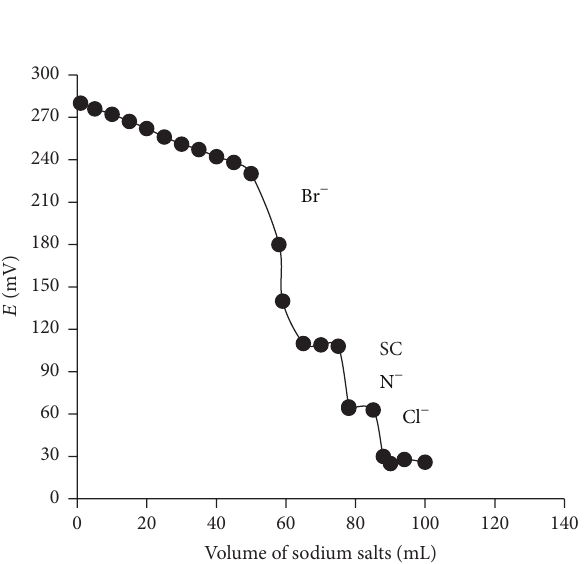
Figure 4: Titration curve of Tl(I) with EDTA using CPE8 as indi- cator electrode.